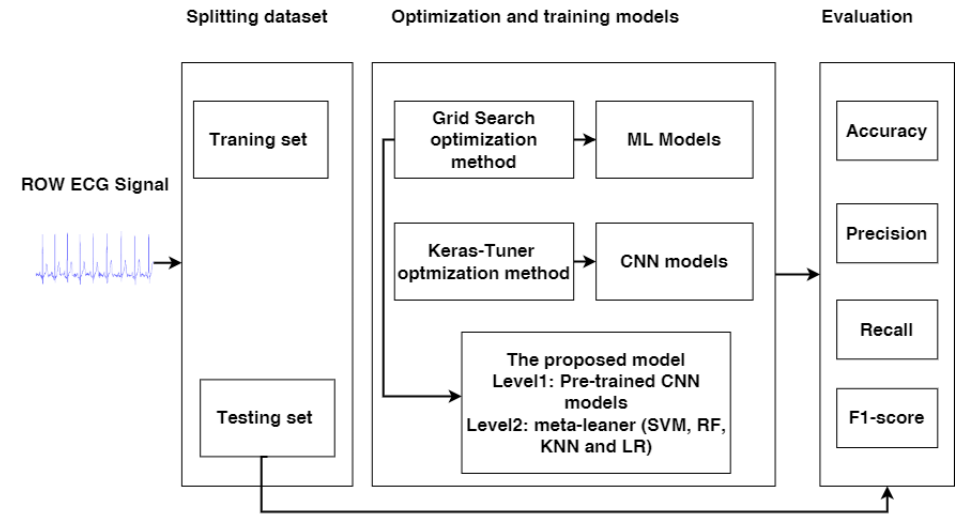
Figure 1. The complete process used for prediction